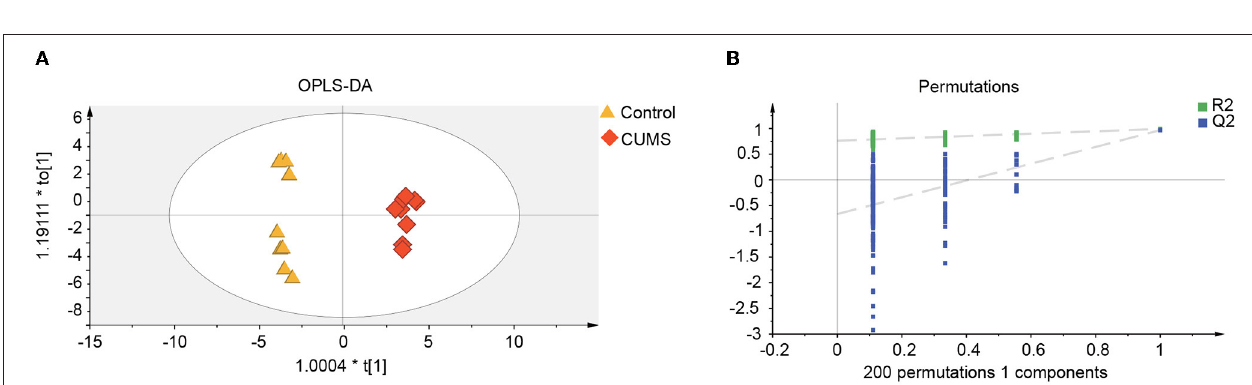
Frontiers in Psychiatry |